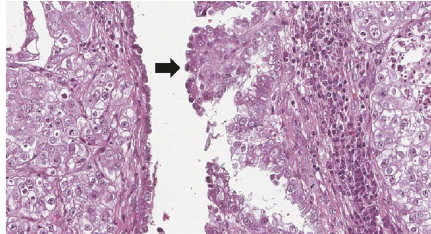
Figure5:Microscopicexaminationshowspartofatinycystlinedby cuboidal cells with atypical nuclei that had merged with the tumor indicating residual foci of atypical endometriosis